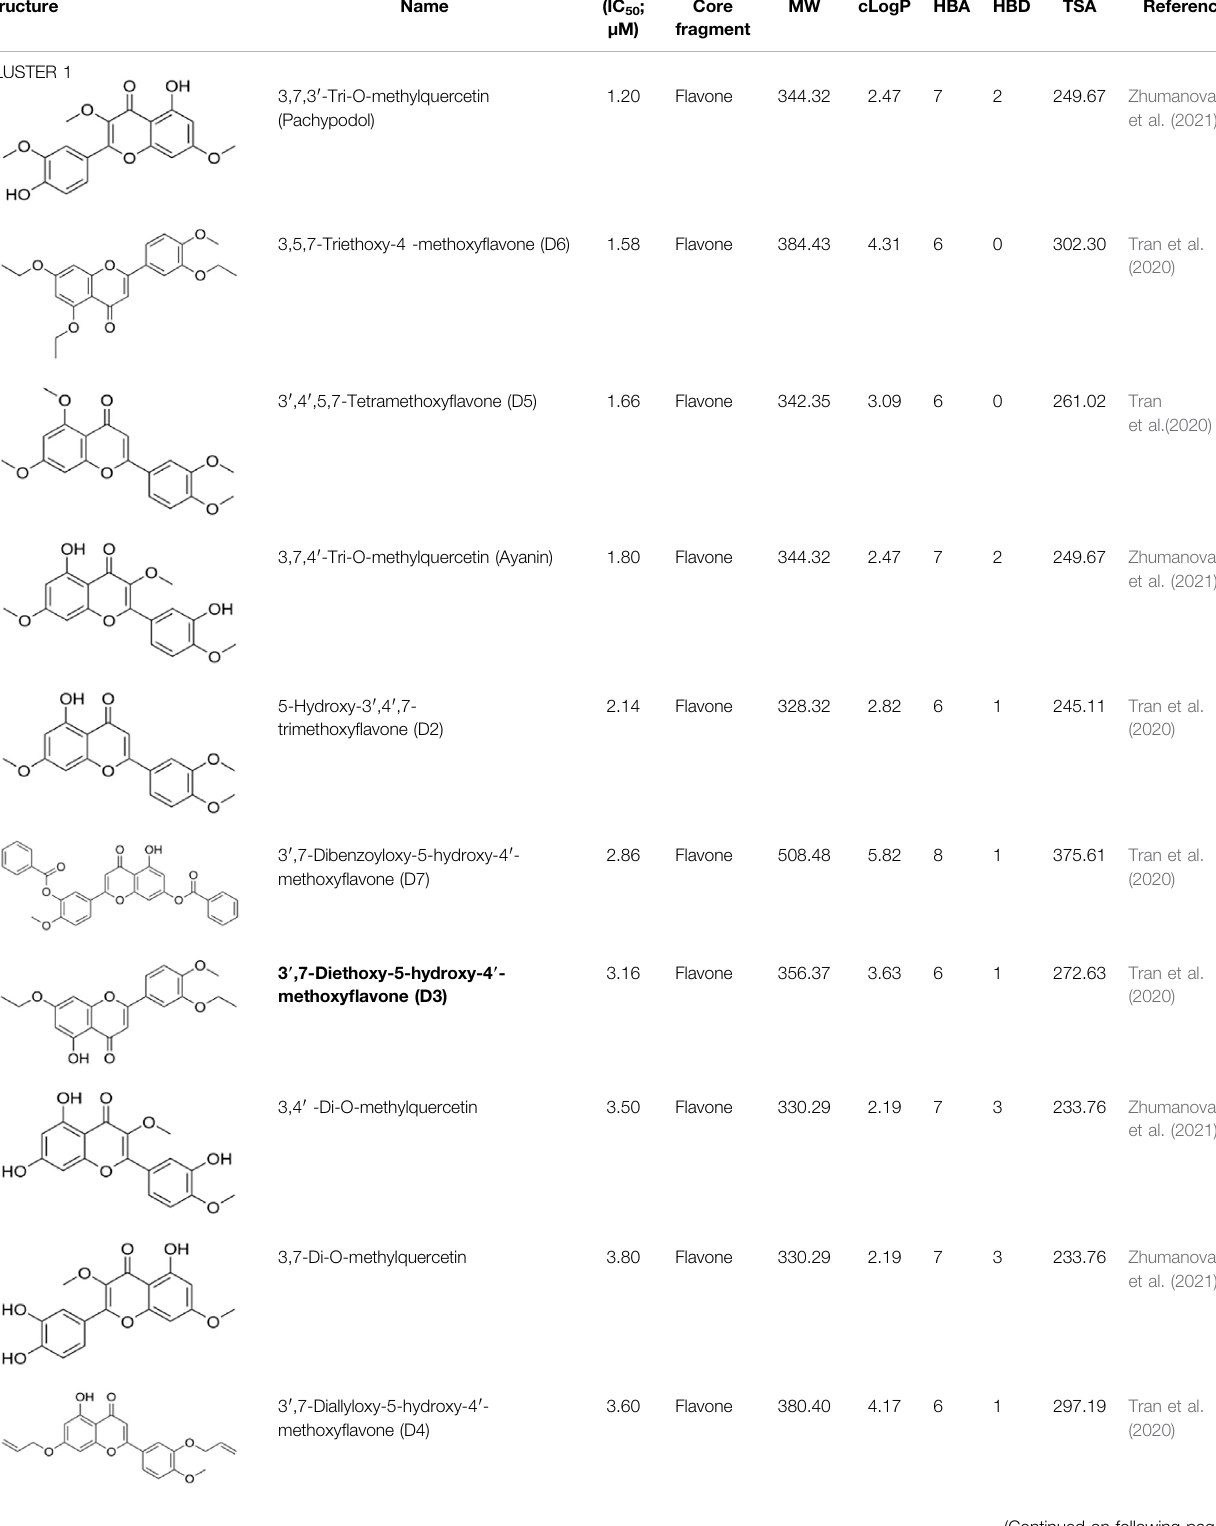
TABLE 3 | Information of the 64 fl avonoid compounds that were fi ltered and classi fi ed according to their cluster.